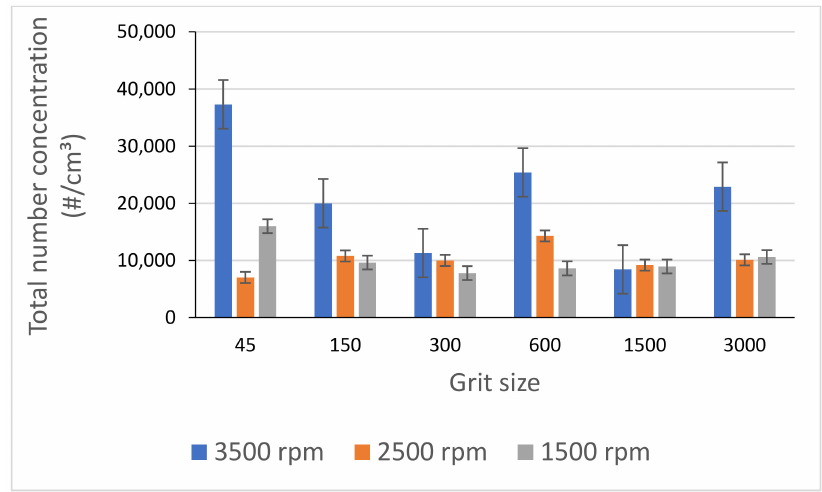
Figure 10. Total number concentration of FP while grinding white granite for different grit sizes (f = 1000 mm/min).